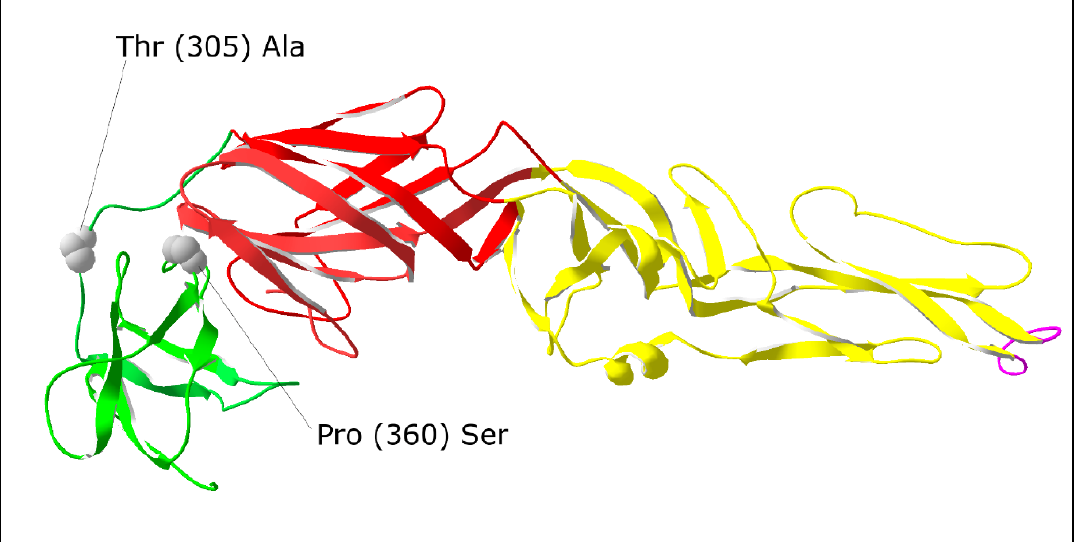
Figure 4. Locations of amino acid substitutions in the TBEV variant 40 PS mapped on the three- dimensional structure of flavivirus E protein (PDB: 1SVB). Domain I — red, domain II — yellow, domain III — green, fusion loop — violet.